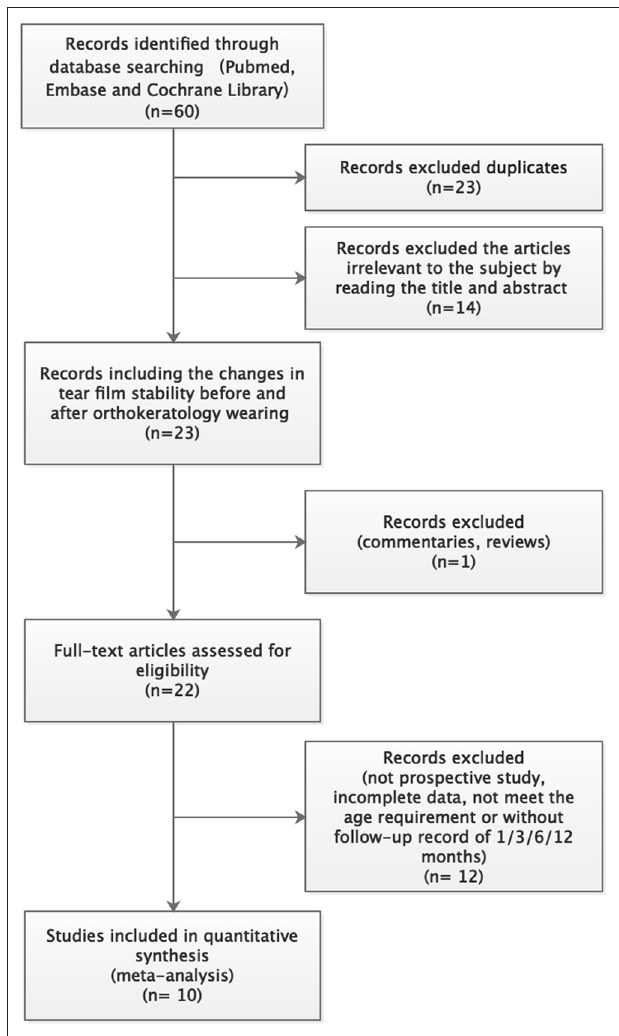
FIGURE 2 | The detailed literature screening